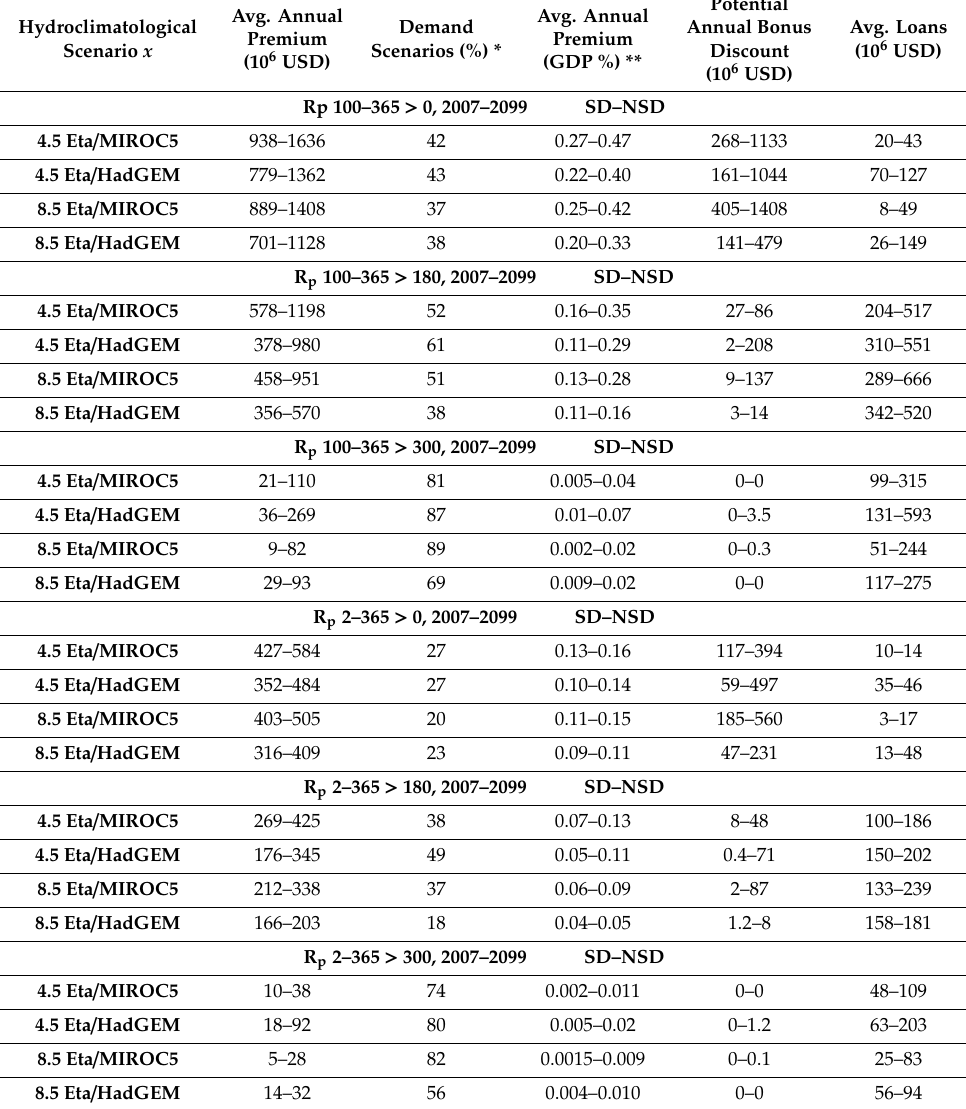
Table 4. Insurance scheme results under main analysis